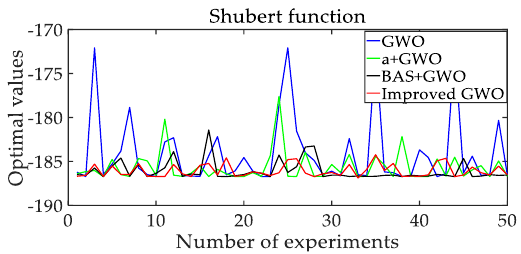
Figure 3. Shubert function convergence curve.